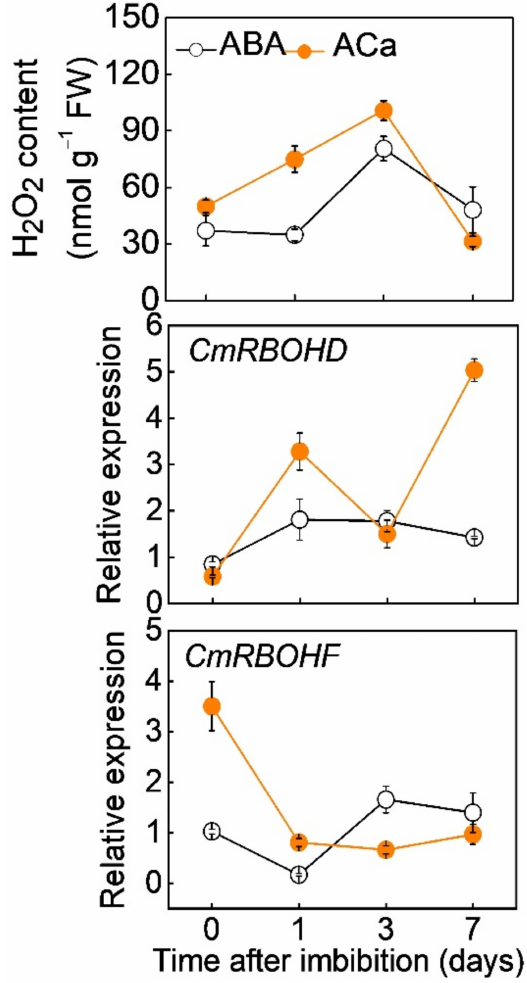
Figure 4. The effects of ABA and combination of ABA and CaCl 2 (ACa) on the H 2 O 2 accumulation and the relative expression of CmRBOHD and CmRBOHF during melon seed incubation. Data are means ± SD (3 replicates × 30